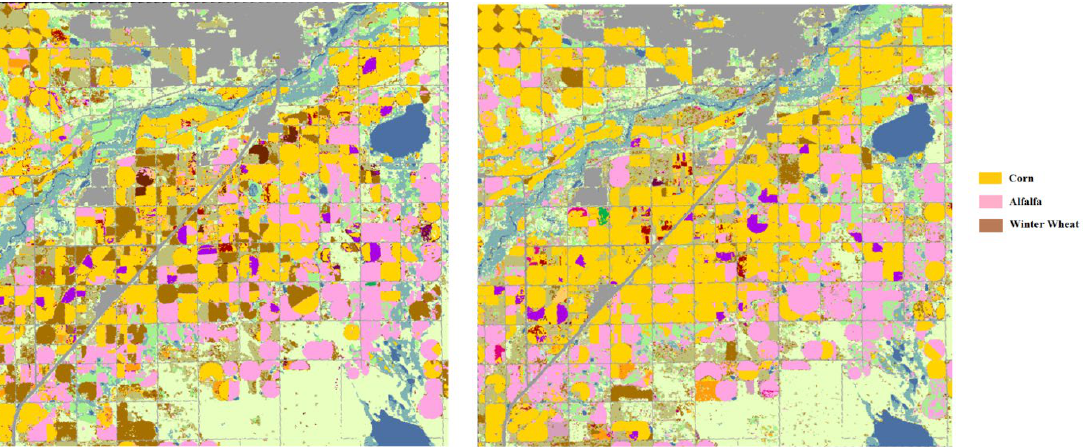
Figure 5. Crop type distribution in the study area from NASS satellite. The left figure is the crop map in 2013 and the right one is in 2018. in 2013 and the right one is in